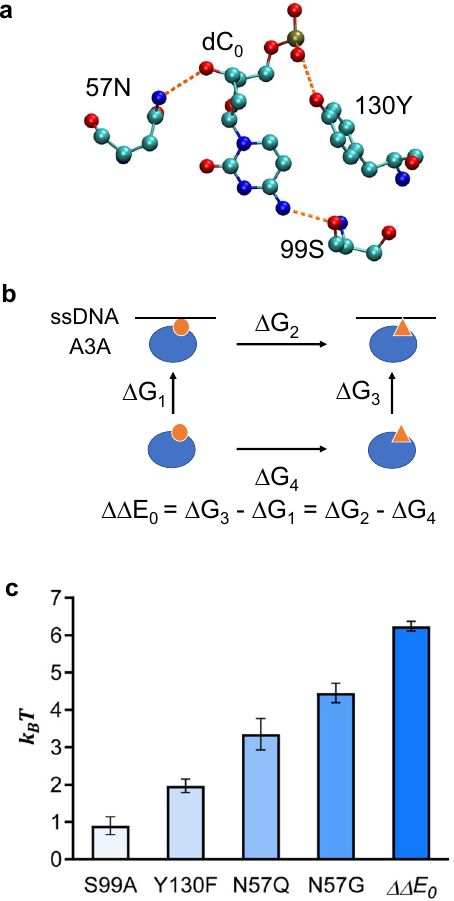
Fig. 2 Calculation of binding free energy changes between ssDNA binding motif and A3A deaminase under various mutations. a Hydrogen- bonding network between cytidine dC 0 and A3A residues 57, 99 and 130. b Thermodynamic cycle used to calculate the binding free energy changes: ssDNA (black line), A3A (blue balloons). A mutation at the binding interface is shown by a transition from small orange circle to orange triangle. c Computationally estimated changes in binding free energy for A3A deaminase mutations S99A, Y130F, N57Q, N57G and binding free energy change between A3A binding to target and bystander cytidines. The energy unit is k B T and T = 300 K. Data are presented as mean values ± s.e.m, estimated by Bennett ’ s acceptance ratio method for 200,000 data points. Source data are provided as a Source Data fi